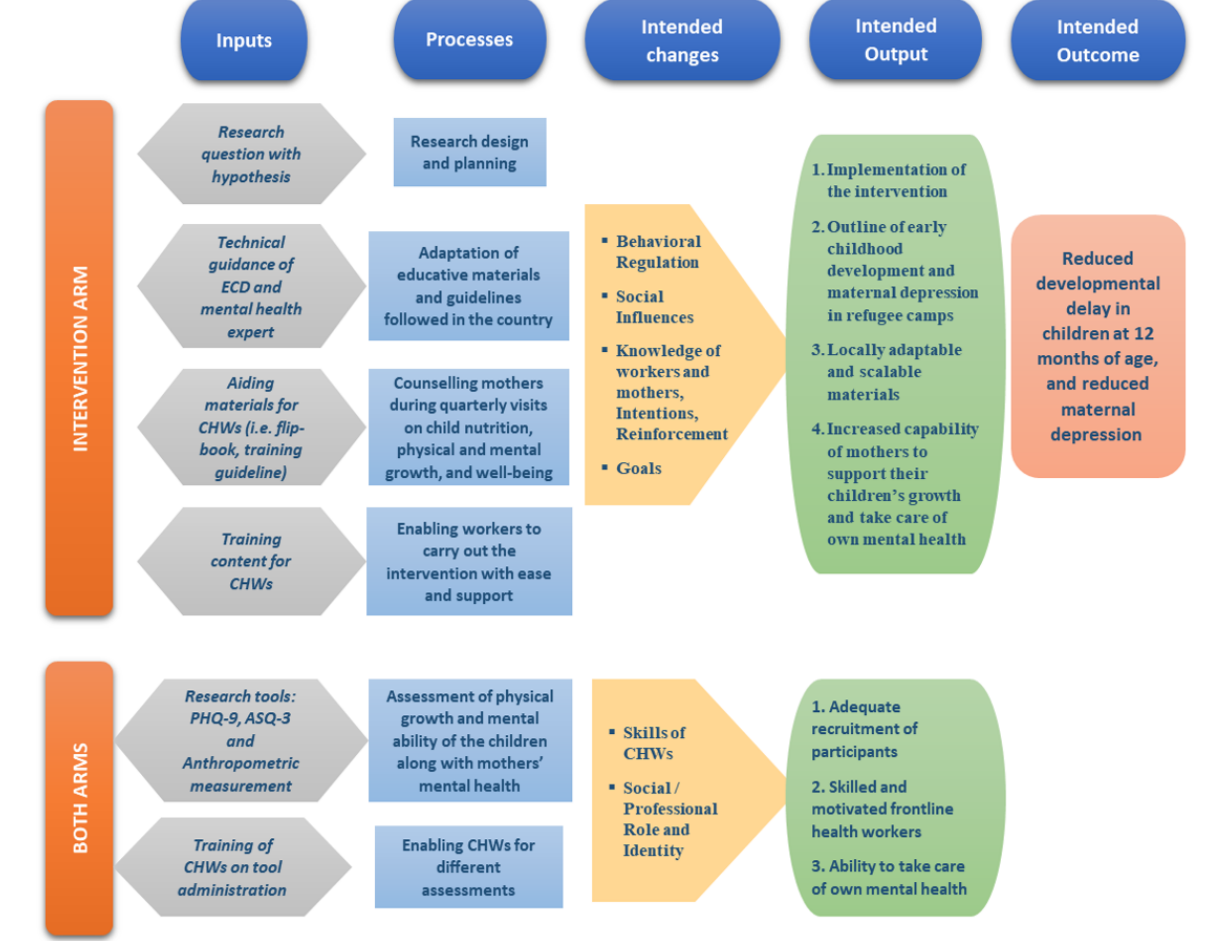
Figure 1. Logic model for intervention mechanism. CHW: community health worker; ECD: early childhood development; ASQ-3: Ages and Stages Questionnaire third edition; PHQ-9: Patient Health